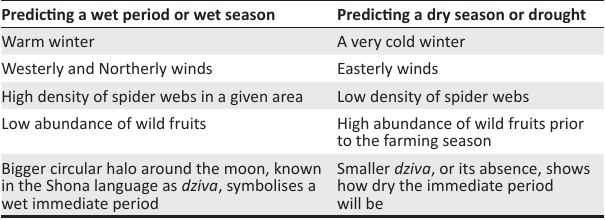
TABLE 1: Indigenous rainfall predictions used in Buhera and Chikomba. Predicting a wet period or wet